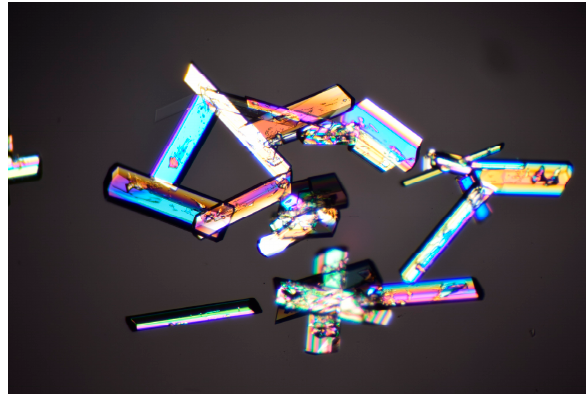
Figure 4. Polarized light microscopic picture at 40× magnification of Fondaparinux crystals formed from a water/ethanol solution.